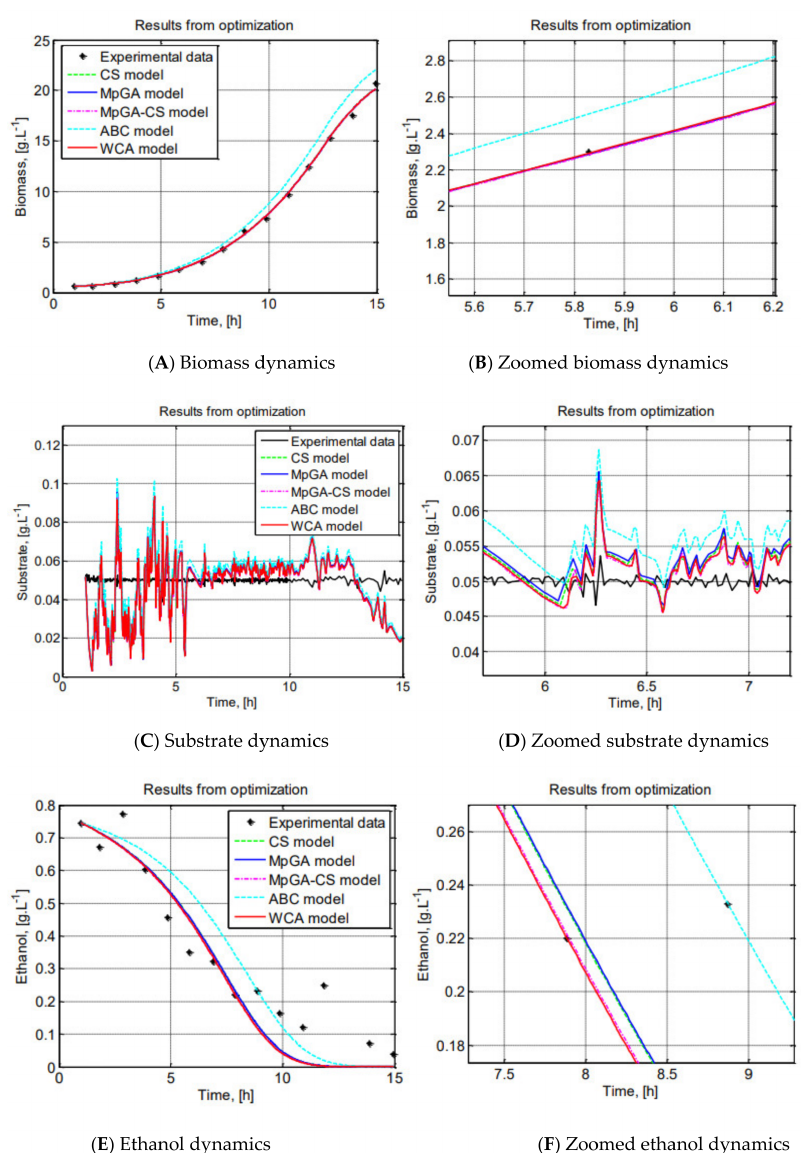
Figure 7. Graphical comparison of the results from parameter identification of S. cerevisiae FP model. Once again, the performance of the five algorithms is statistically evaluated by com- parison of the observed average value, standard deviation, and median of the estimated model parameters and the objective function value J . To visualize summary statistics for S. cerevisiae parameter identification, box plot diagrams are shown in Figure